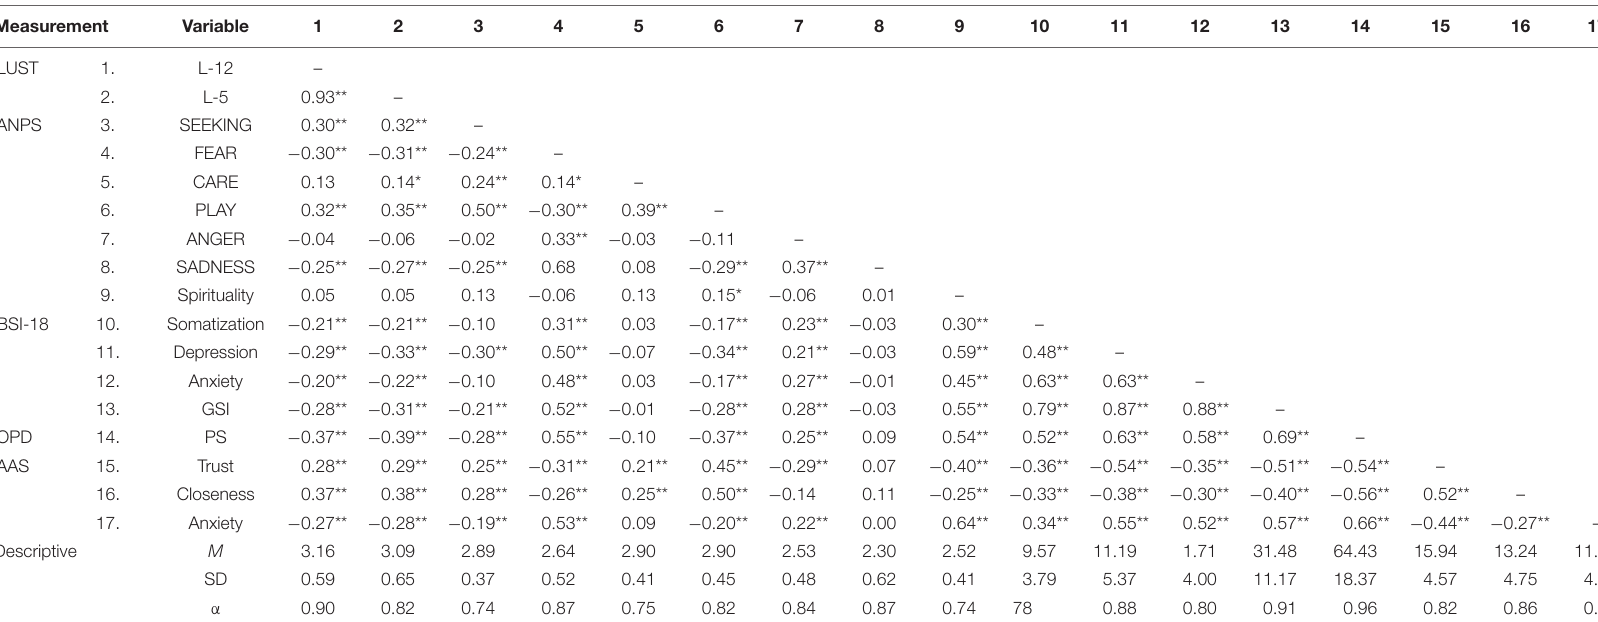
TABLE 3 | Descriptive statistics, internal consistency and correlations between the L-scales and measures of personality structure as well as psychiatric symptom burden.